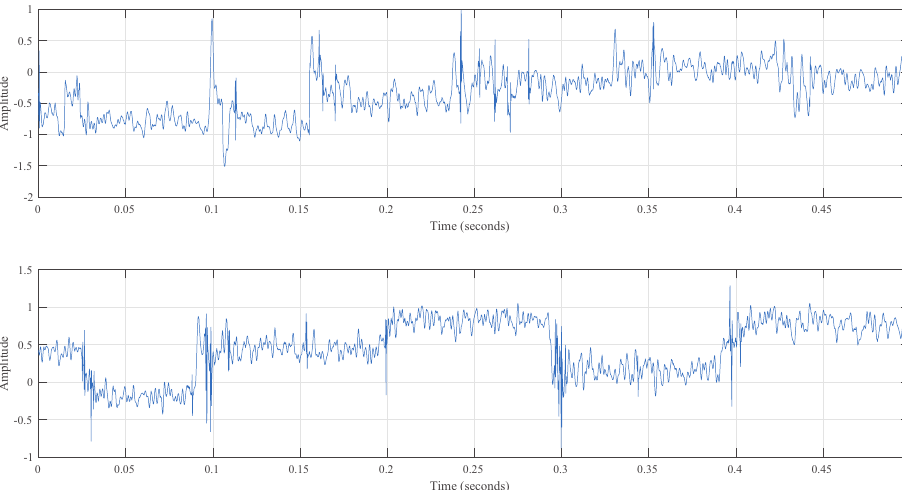
Figure 8. Improved wavelet denoising results for two actual welding